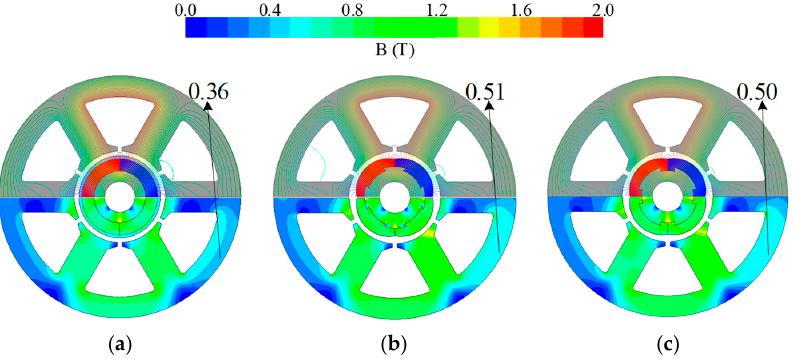
Figure 7. No-load flux density distribution of SPM and SIPM motors. ( a ) SPM. ( b ) SIPM1. ( c ) SIPM2.